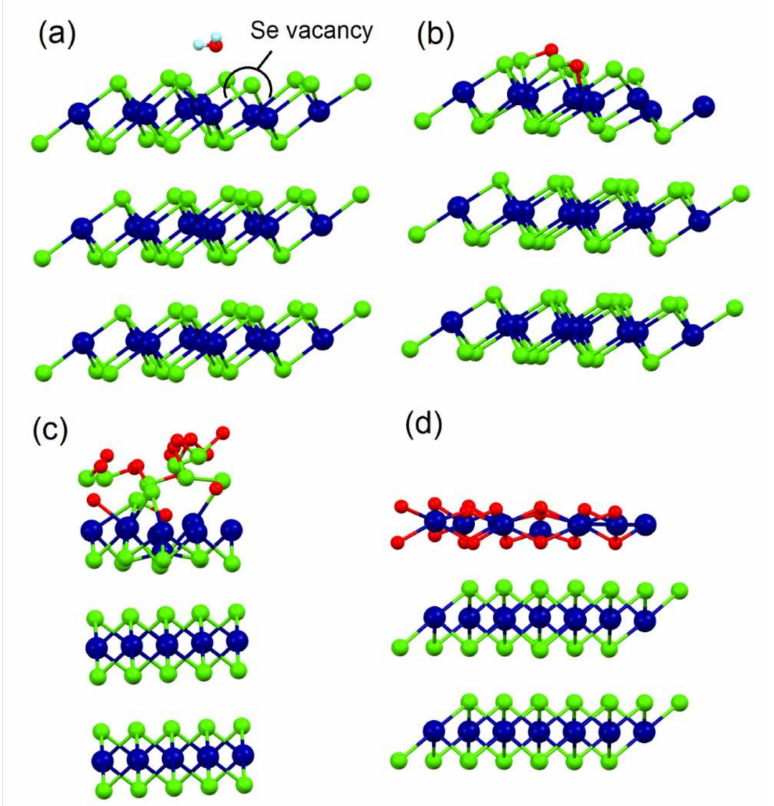
Figure 2. Optimized atomic structure of ( a ) water molecules physisorbed at one Se-vacancy site; ( b ) decomposed oxygen molecule on SnSe surface layer; ( c ) metastable SnSe 2 O 2 surface layer; and ( d ) SnO 2 -skin-terminated SnSe 2